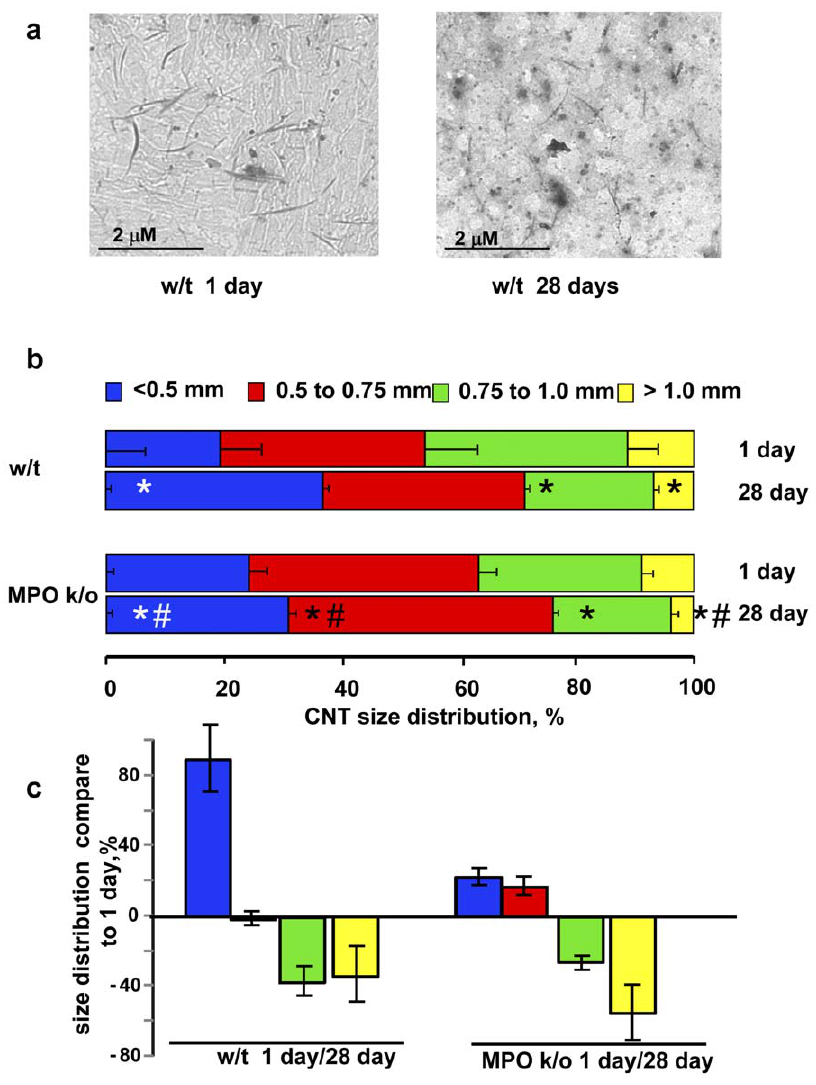
Figure 4. Evaluation of SWCNT size distribution in solubilized lungs of w/t and MPO k/o mice at days 1 and 28 post exposure by t ransmission electron microscopy. a. Typical TEM images of SWCNT after solubilization of the lung tissue. b. Size distribution of SWCNT present in the lung at days 1 and 28 post exposure. * p , 0.05, vs w/t 1 day post exposure, # p , 0.05, vs w/t 28 days post exposure. c. Changes in size distribution of SWCNT at day 28 post exposure compared to day 1 post